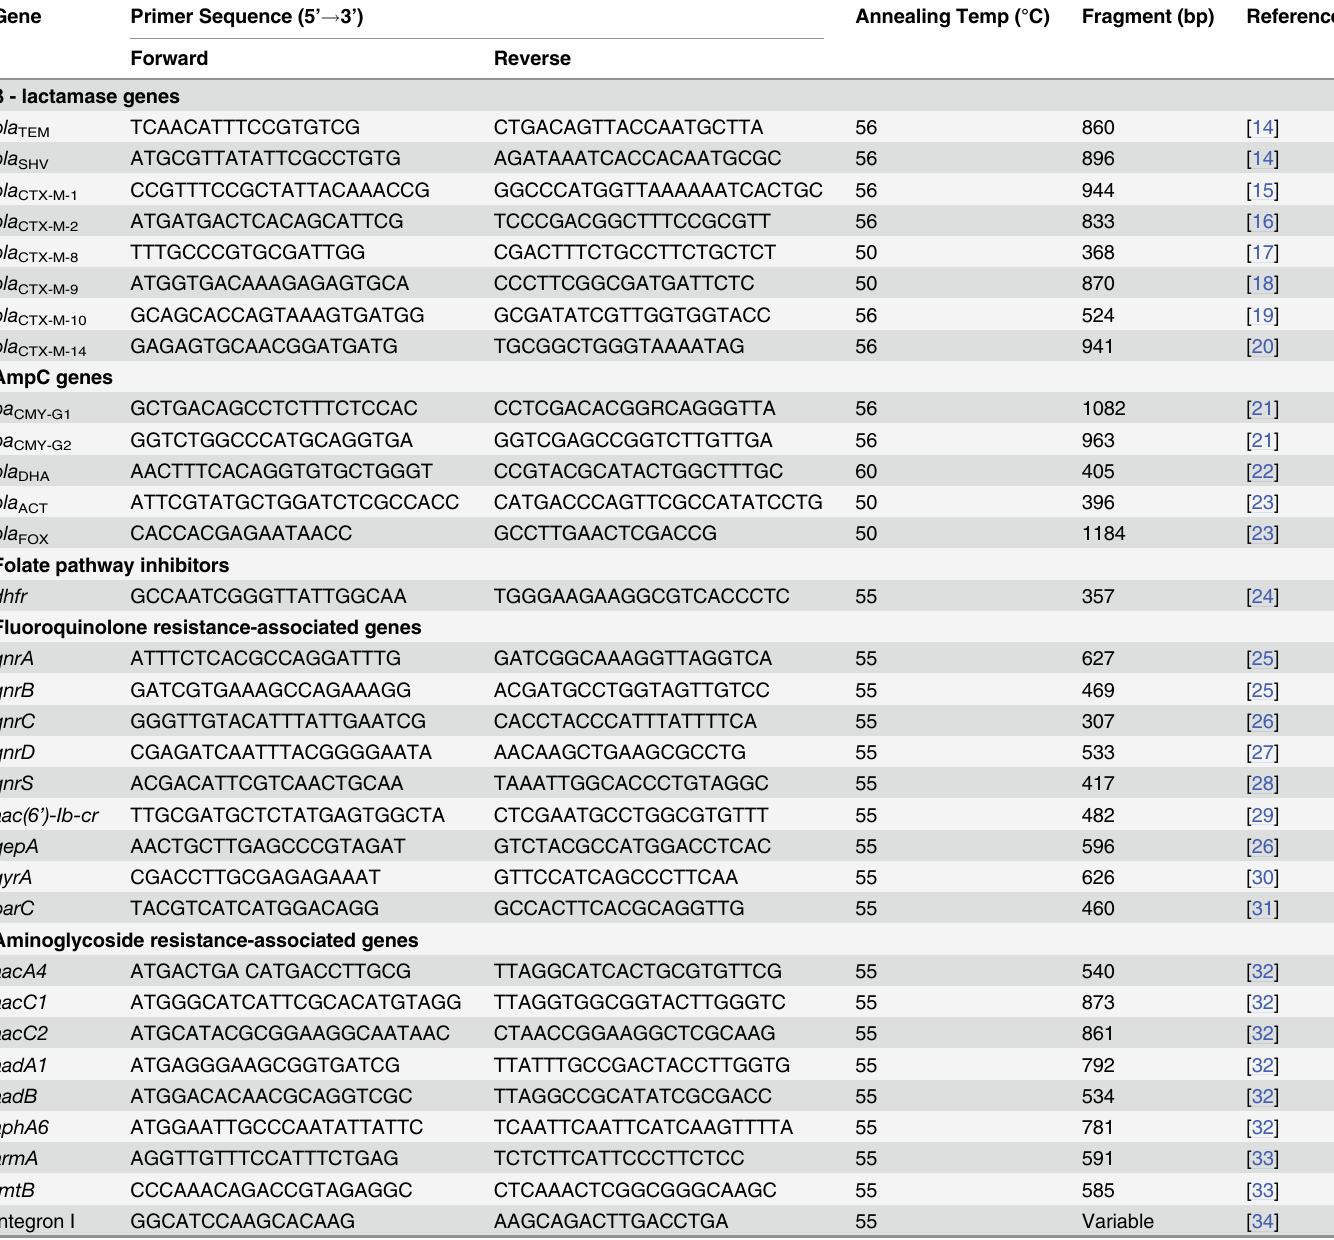
Table 1. Primers Used for PCR Amplification and Resistance Gene